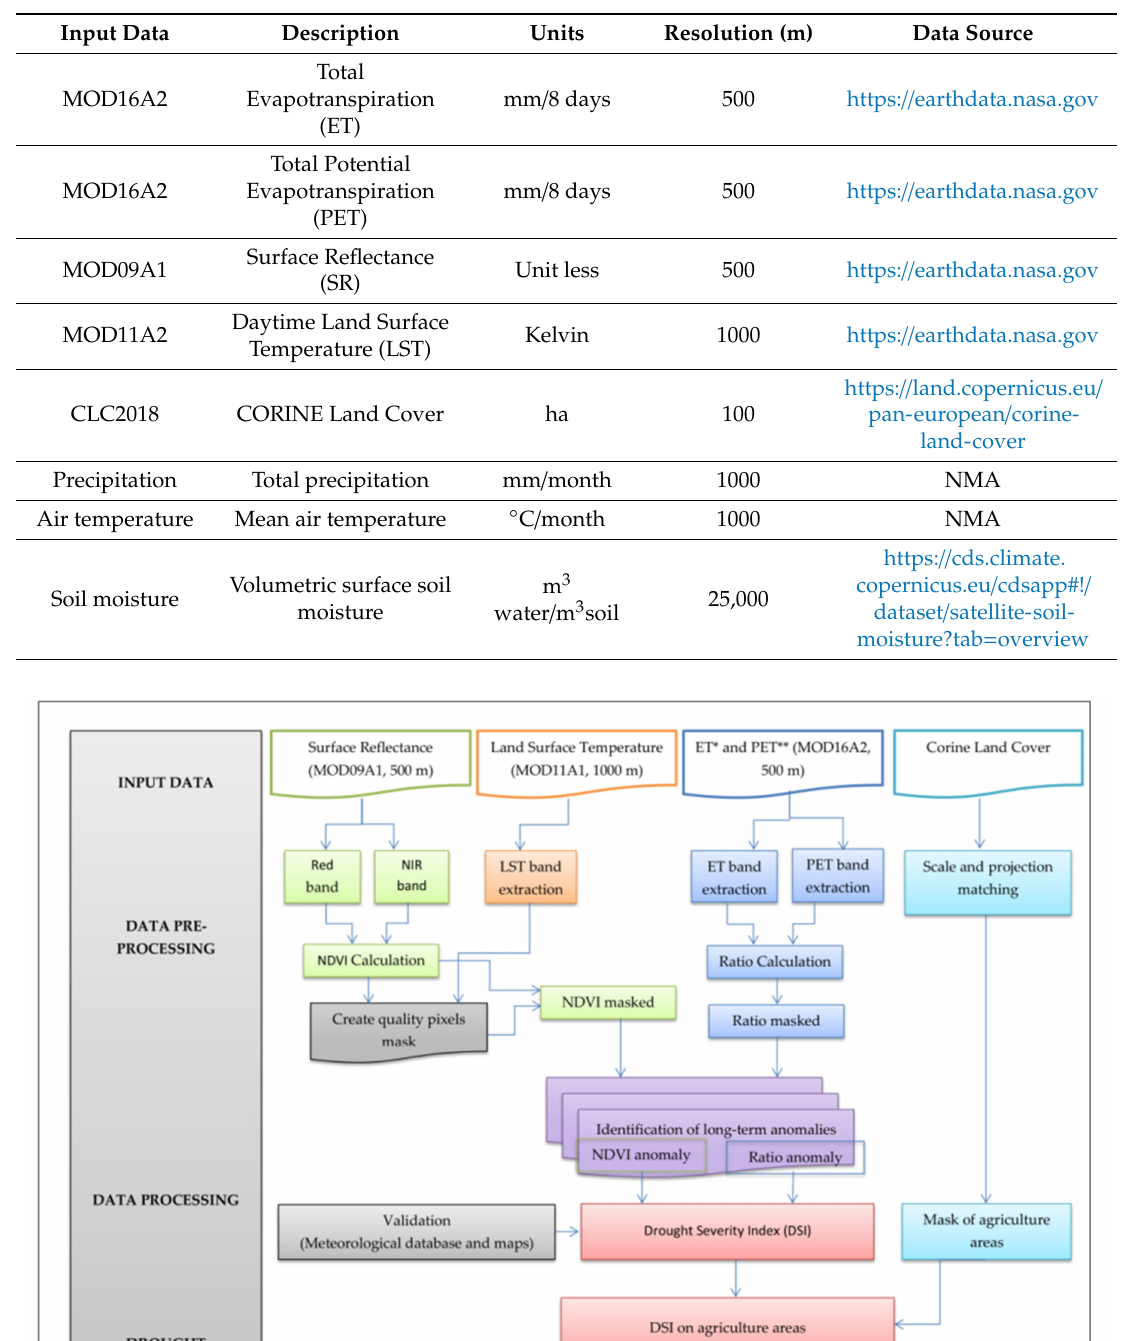
Table 2. Data used.